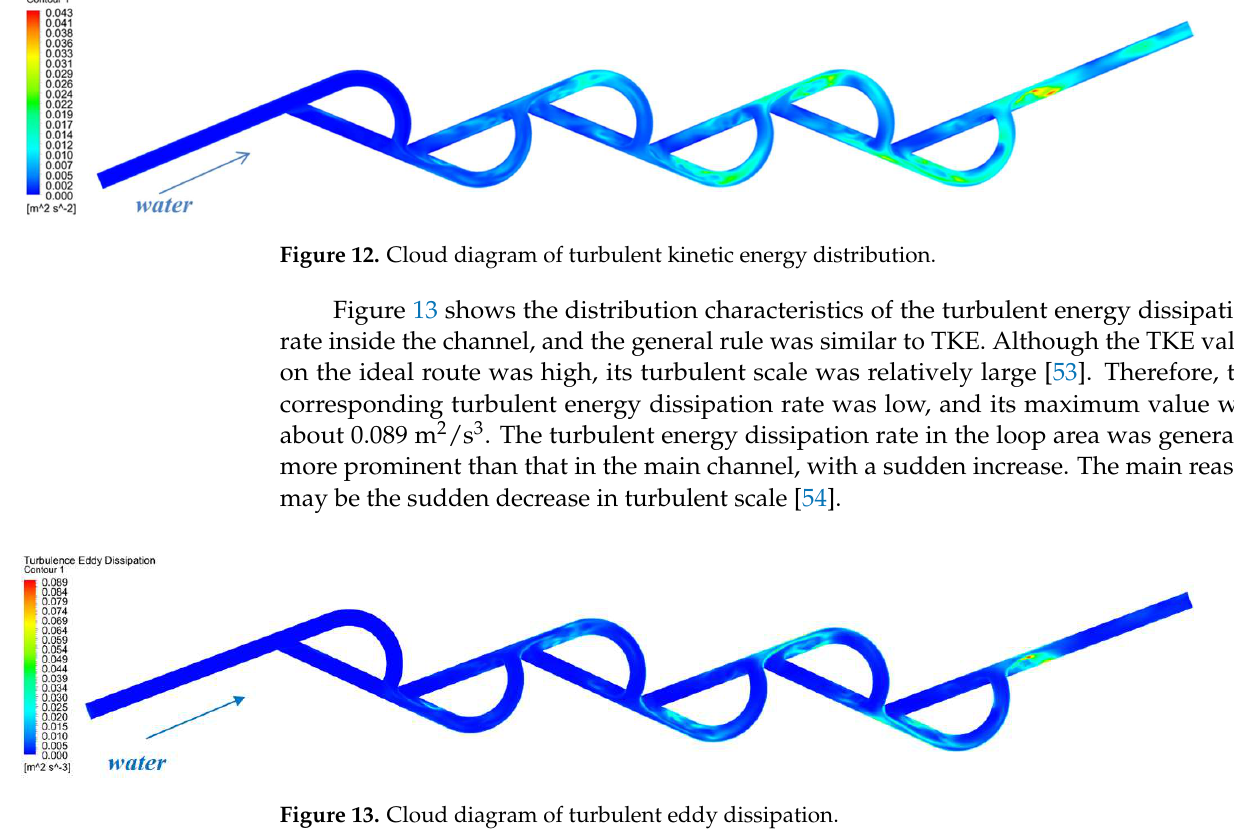
Figure 13. Cloud diagram of turbulent eddy dissipation.